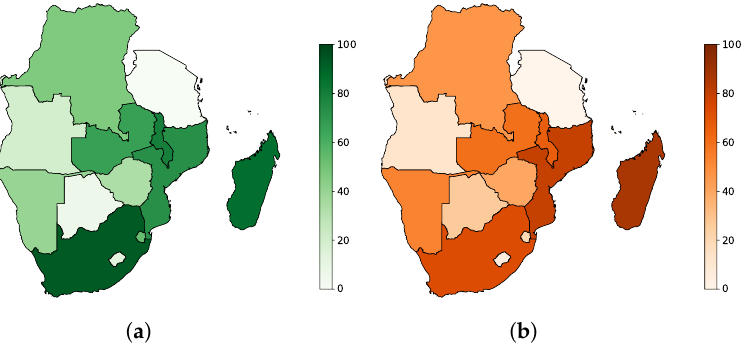
Figure 8. MES-LSTM Forecast Accuracy Ranked for Each Country in the SADC Region. ( a ) sMAPE for total cases . ( b ) sMAPE for total deaths .